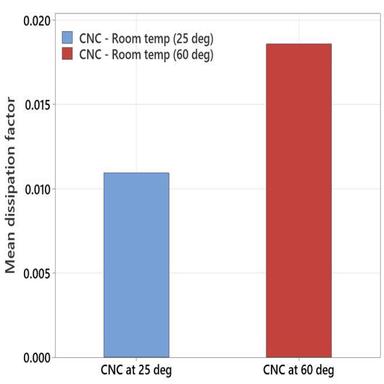
Mean dissipation factor for CNC at two different conditions; at room (25 ℃) and elevated (60 ℃) temperatures.